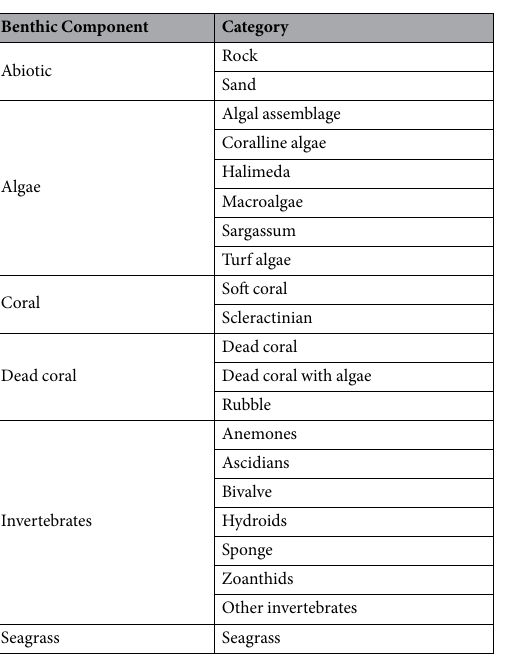
Table 1. Main categories used to define benthic community